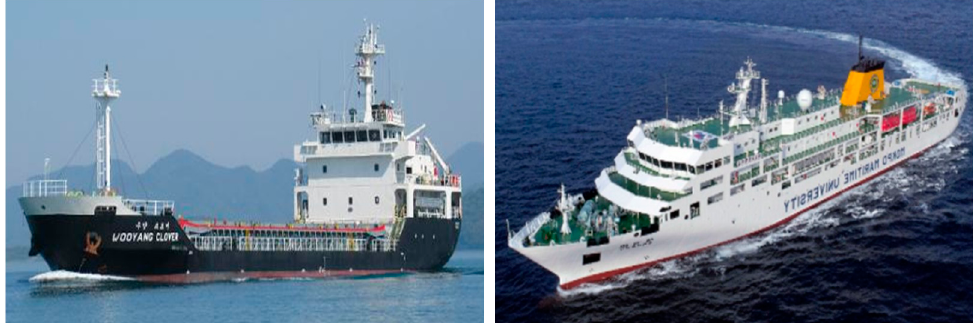
Figure 4. Concept of SEMIS.